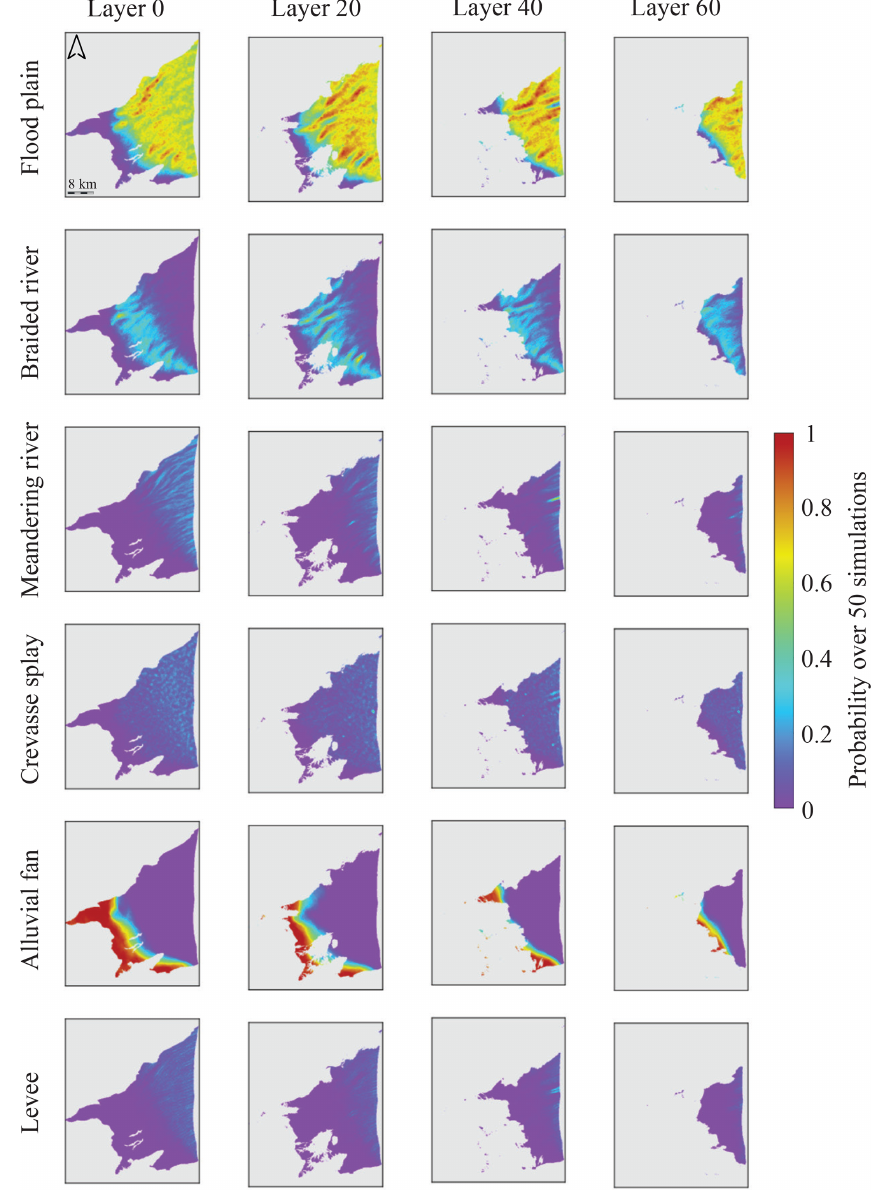
Figure 8. Probability maps of the six simulated facies at different depths. The probability maps are calculated over a 50-simulation set.